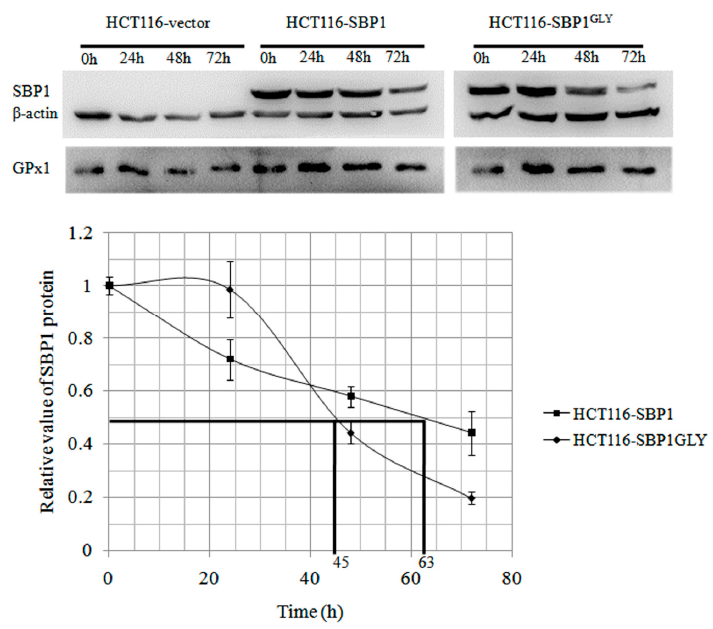
Figure 3. SBP1 GLY has a shorter protein half-life than SBP1. HCT116 cells transfected with vector, pIRES2-SBP1, or pIRES2-SBP1 GLY were treated with 100 µg/mL cycloheximide for 24, 48 and 72 h and then protein levels of SBP1 were determined by immunoblot analysis. The signals were quantified by densitometry using ImageJ Software and normalized to β -actin. The determined half-life of SBP1 and SBP1 GLY were 63 and 45 h in HCT116 cells which has a statistically significant difference ( p < 0.05).